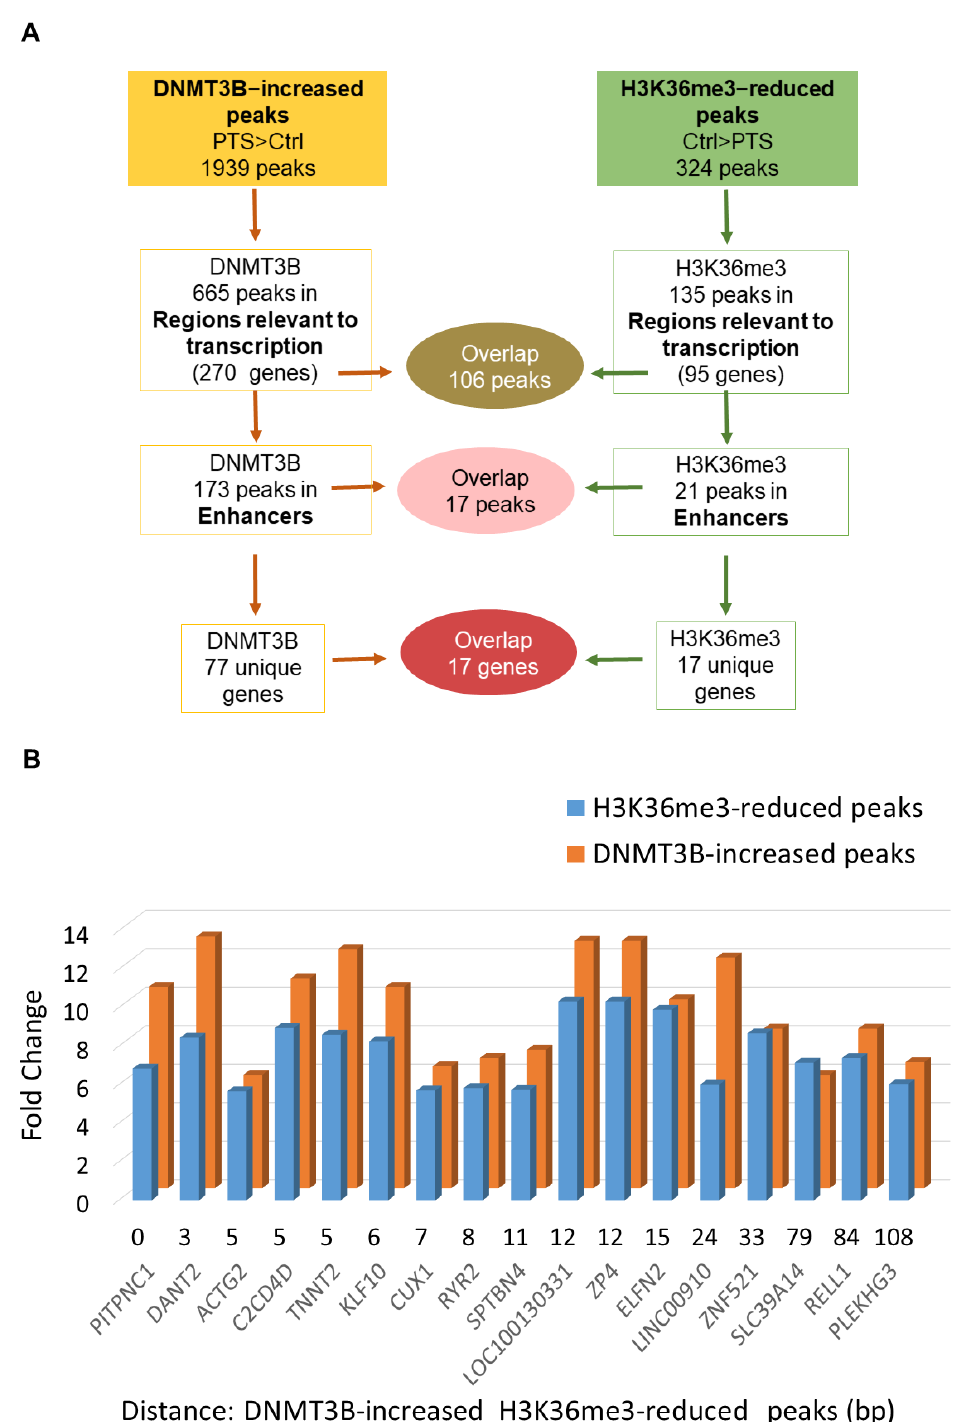
Figure 2. Characterization of regions and genes that contain overlapping DNMT3B-increased and H3K36me3-reduced peaks in response to PTS. ( A ) Schematic of the analysis of peaks and genes associated with DNMT3B-increased and H3K36me3-reduced peaks in MCF10CA1a breast cancer cells treated with 7 μM PTS for 9 days. The overlap between peaks located within regions relevant to transcription (i.e., promoters, enhancers, insulators, Polycomb-repressed regions, or heterochromatin) and specifically enhancers is depicted along with the number of corresponding genes. ( B ) The 17 overlapping peaks located in enhancer regions and the corresponding genes are shown in the bar chart that computes a difference (fold change) in DNMT3B binding and H3K36me3 enrichment between PTS-treated and control cells (vehicle-treated, ethanol), along with the distance between DNMT3B-increased and H3K36me3-reduced peaks in a given gene. The presented results are based on ChIP-seq